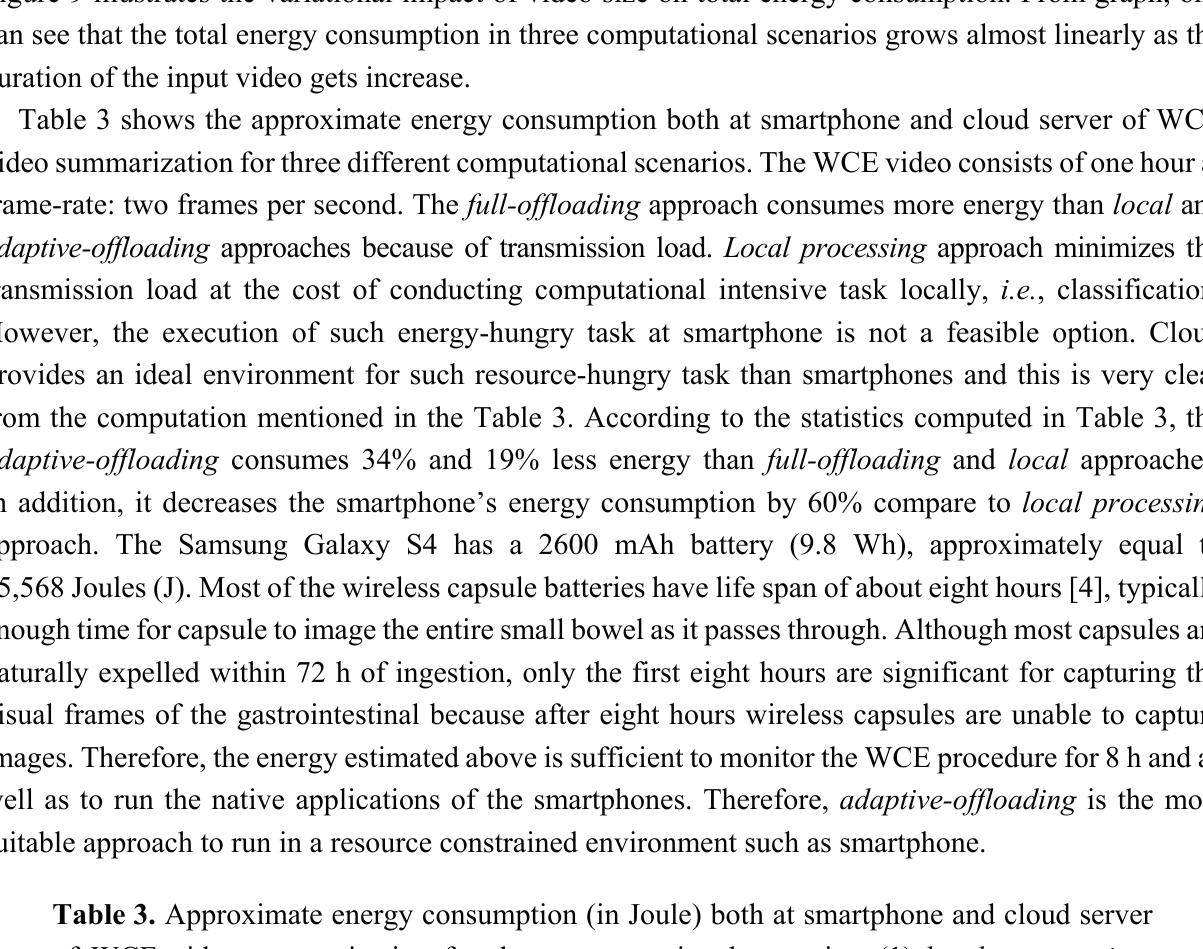
Table 3. Approximate energy consumption (in Joule) both at smartphone and cloud server of WCE video summarization for three computational scenarios: (1) local computation